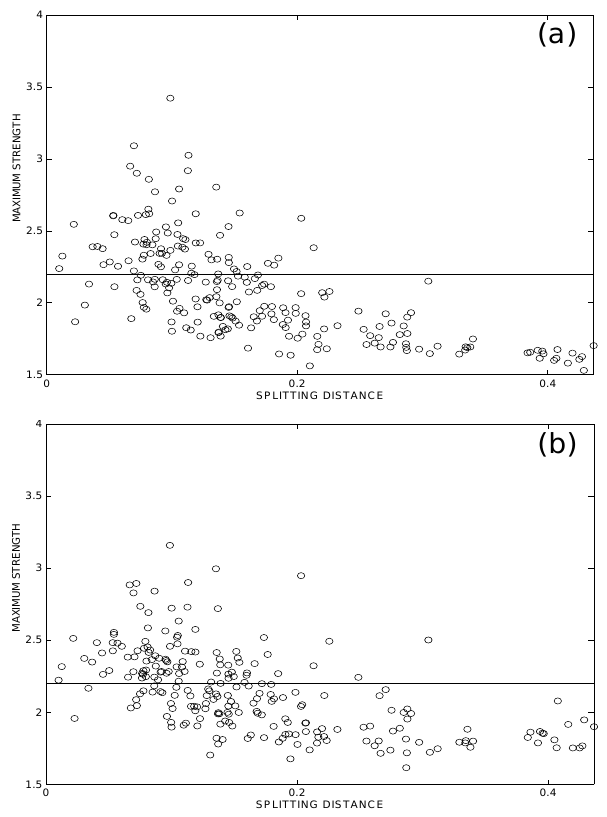
Fig. 19: Maximum strength vs. splitting distance δ ( λ + ,λ − ) for the HONLS equation ( ǫ = 0 . 05 ) with either (a) linear damping, β = 0 , Γ = 0 . 025 , or (b) nonlinear damping β = 0 . 5 , Γ = 0 .